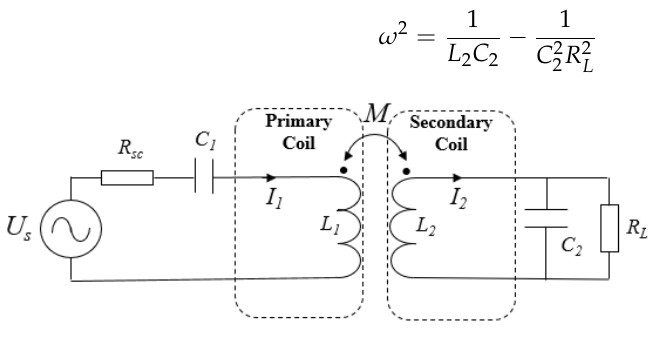
Figure 9. Equivalent WPT circuit by using four-turn split-ring loops.